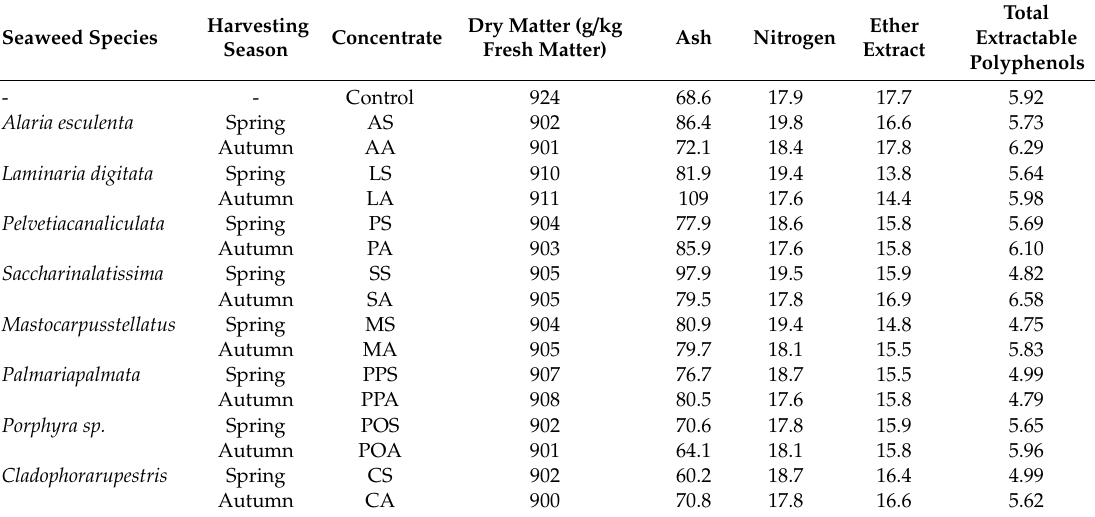
of oat hay and 50% of concentrate either including no seaweeds (control) or di ff erent seaweed species harvested in spring and autumn in northern